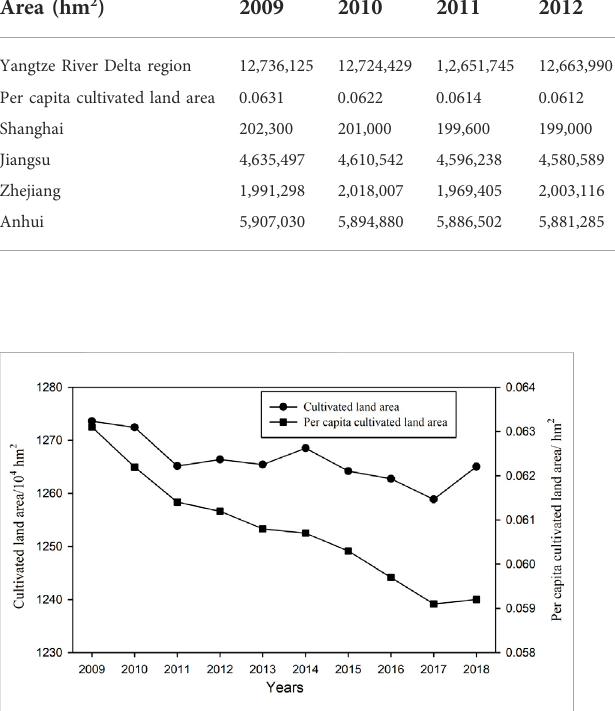
FIGURE 3 Change trend of total cultivated land area and per capita cultivated land area in Yangtze River Delta